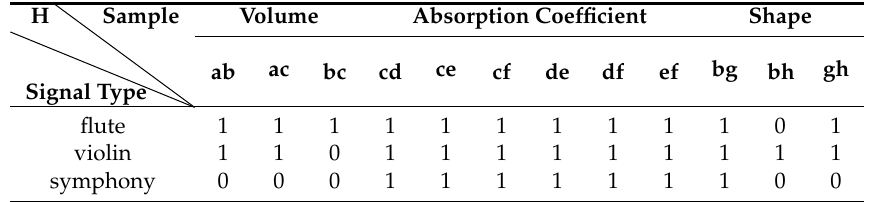
Table 9. Post-hoc of two-factor ANOVA. The samples are hypothesized to be of no significant difference ( α = 00.05). H = 0 denotes that the hypothesis is accepted, while H = 1 denotes that the hypothesis is